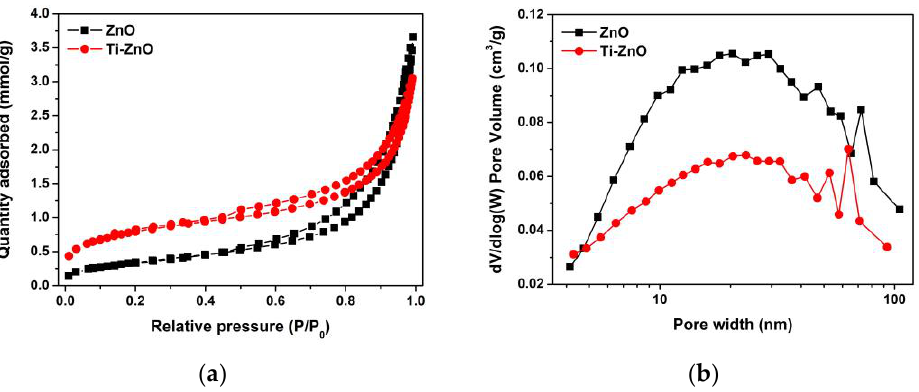
Figure 9. ( a ) N 2 adsorption – desorption and ( b ) pore width distribution for ZnO and Ti-ZnO NPs.